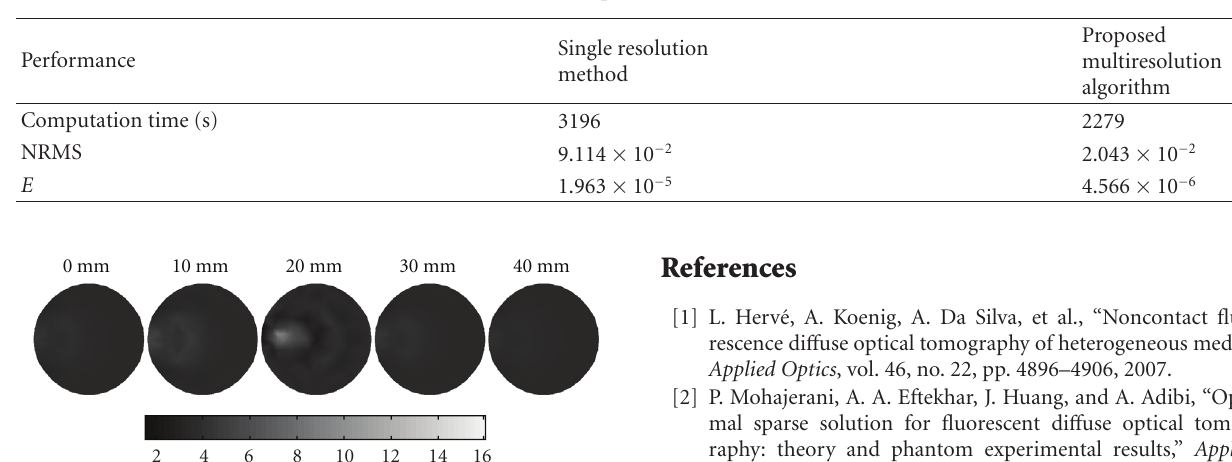
Table 4: Performance comparison of reconstruction methods.